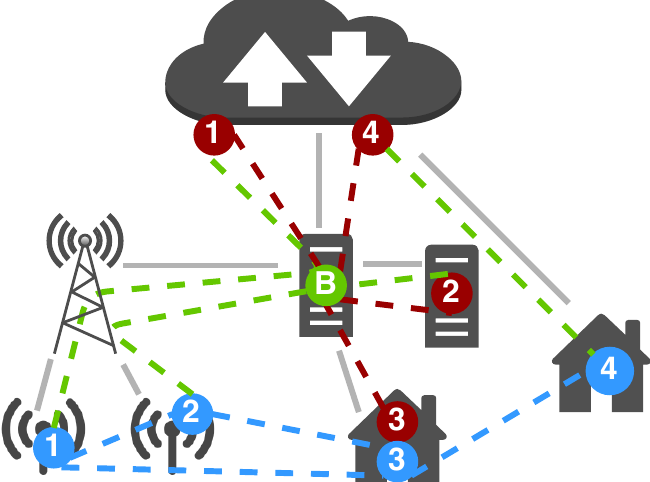
Figure 6. Abstract architecture of the experiment, graphical elements share the semantics of Figure 1c, with some additional elements: red dashed lines represent platform-level MQTT communications; small antennas identify thin hosts (LoRa motes); large antennas are LoRa gateways, houses depict situated thick devices, and vertical gray rectangles symbolize edge servers. The green circle with a B marks a MQTT broker, which can be deployed on edge servers as in the figure, or in the